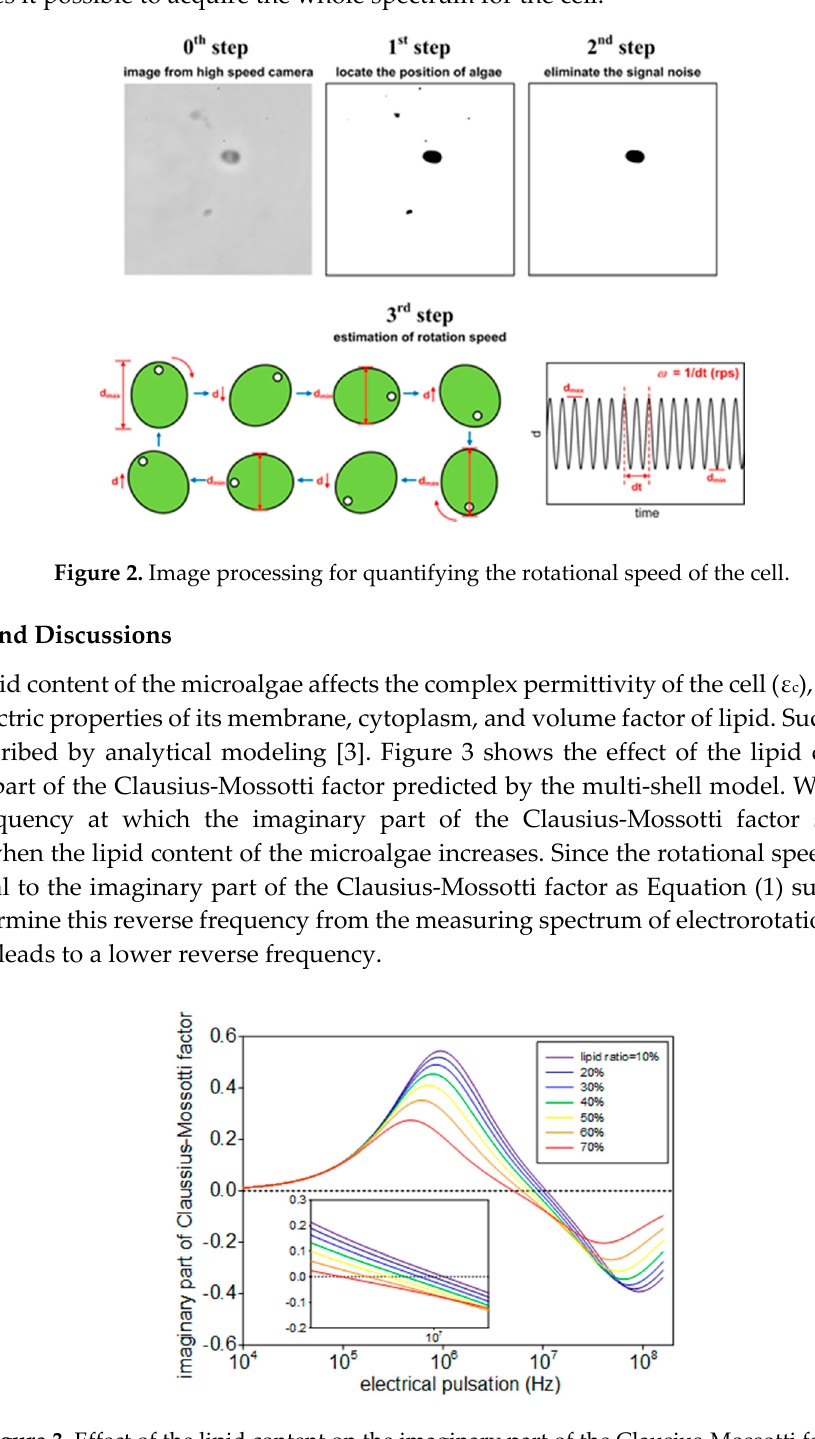
Figure 3. Effect of the lipid content on the imaginary part of the Clausius-Mossotti